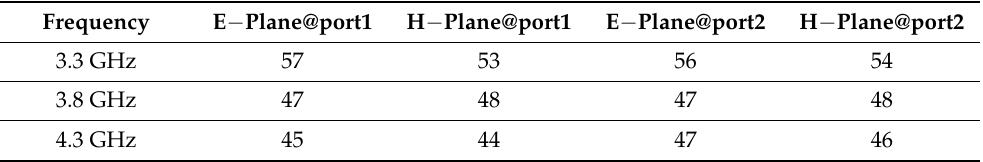
Figure 8. Simulated and measured normalized radiation patterns of port 2: ( a ) E − plane@ 3.3 GHz; ( b ) E − plane@ 3.8GHz; ( c ) E − plane@ 4.3GHz; ( d ) H − plane@ 3.3GHz; ( e ) H − plane@ 3.8GHz; ( f ) H − plane@ 4.3 GHz. Table 2. Results of measured 3 dB beamwidth. (Units: deg).